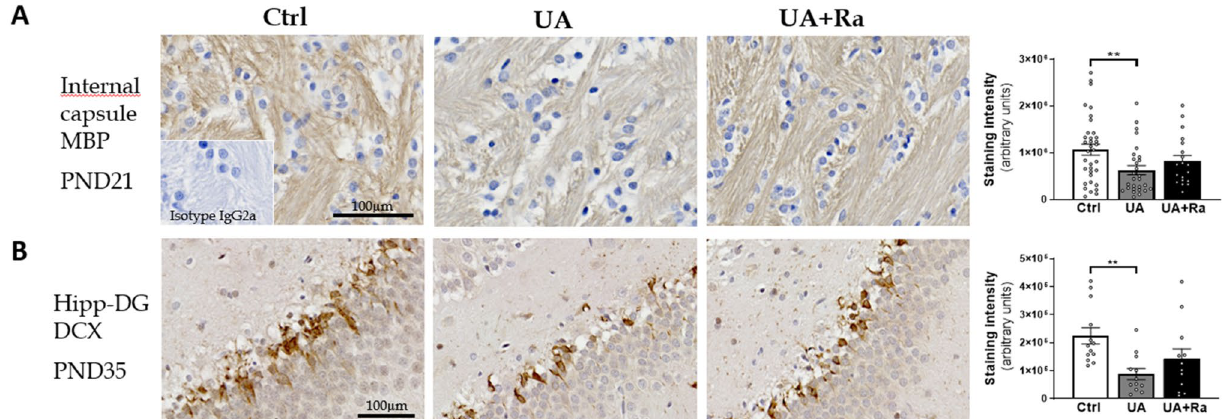
Figure 5. Myelin and neuronal precursor cell histological analysis following uric acid alone or with IL-1Ra prenatal treatment. Injection of uric acid during gestation decreased the myelin staining intensity in the internal capsule at PND21 ( A ) and decreased doublecortin staining in the hippocampus-DG at PND35 as opposed to the control group ( B ). Prenatal treatment with IL-1Ra did not statistically preserve these regions. N = 8–16 litters (i.e. PBS = 11; IL-1Ra = 8; UA = 16; UA + Ra = 12) for MBP and N = 6 litters/group for DCX. **p < 0.01. Results presented as mean ± SEM. Statistical analysis by one-way ANOVA with Tukey’s multiple comparisons test with GraphPad Prism 9.2.0 (GraphPad Software, CA); www. graph pad.